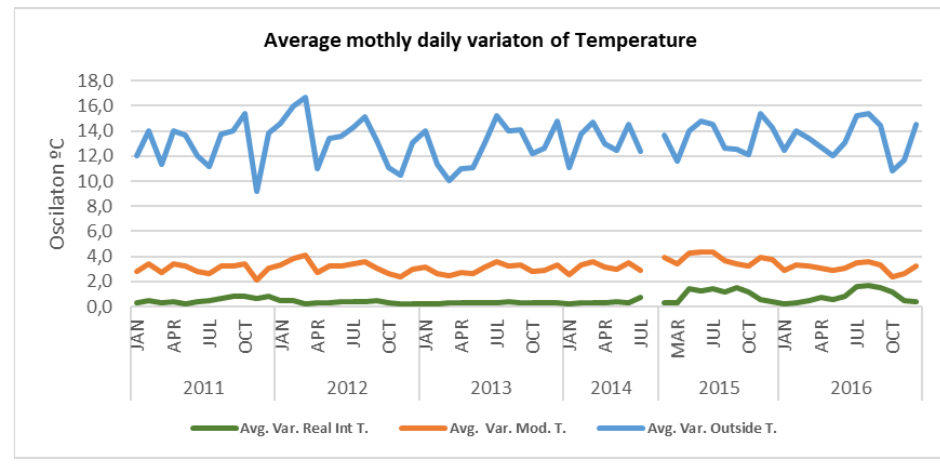
Figure 21. Variation in the average monthly daily temperature for the period of 2011 – 2016.